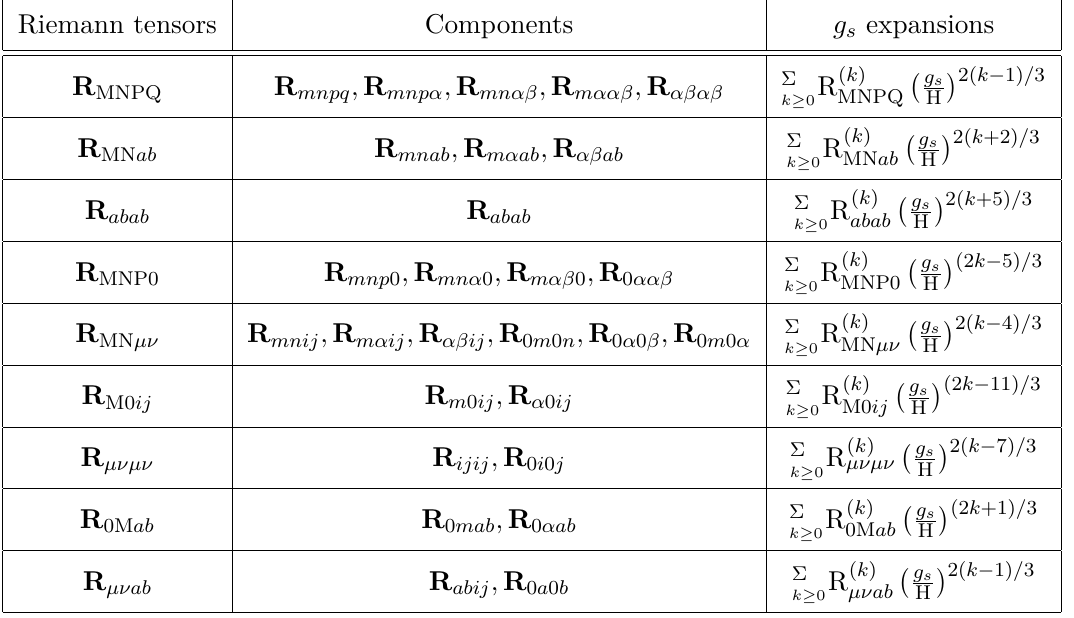
Table 1 . The g s expansions of the various curvature tensors associated with the metric (4.5). Here (M , N) ∈ M 4 × M 2 with a finer sub-division of ( m, n ) ∈ M 4 and ( α, β ) ∈ M 2 . The other components are ( a, b ) ∈ T 2 and ( µ, ν ) ∈ R 2 , 1 . The curvature tensor R ( k ) G where y m ∈ M 4 × M 2 and k ∈ Z . These curvature tensors form the essential ingredients of the 2 quantum terms